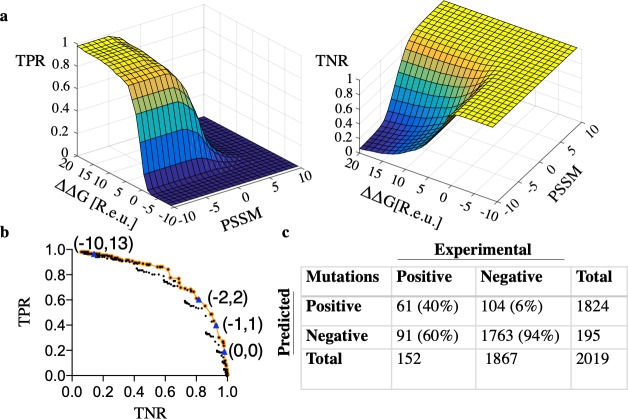
Mutational-tolerance mapping by Rosetta atomistic energy calculations (ΔΔG) and evolutionary-conservation scores (PSSM).(a) Systematic analysis of combinations of PSSM and ΔΔG thresholds reveals an expected tradeoff in prediction accuracy of mutational tolerance. Each combination of thresholds (-10≤PSSM≤10; -10≤ΔΔG≤20 Rosetta energy units, R.e.u.) results in a different fraction of correctly predicted enhancing or deleterious mutations (true-positive rate [TPR] and true-negative rate [TNR], respectively) observed in the deep mutational scanning data of D44.1. (b) All (PSSM, ΔΔG) combinations are plotted with their TPR and TNR values, and the Pareto-optimal front is indicated in orange. Several combinations of (PSSM, ΔΔG) thresholds are indicated by blue triangles. (c) The thresholds (PSSM≥-1, ΔΔG≤+1 R.e.u.) result in a TNR of 94% and TPR of 40% and were used in subsequent design calculations. Optimal ΔΔG cutoffs may vary depending on the energy function and the relaxation protocol. For details on these choices, see Methods.